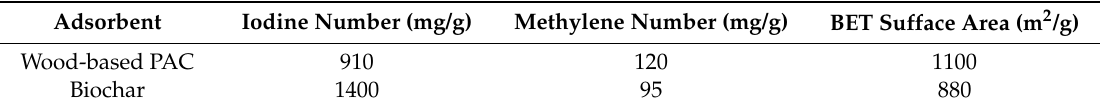
Table 1. Characteristics parameters of virgin materials for adsorption